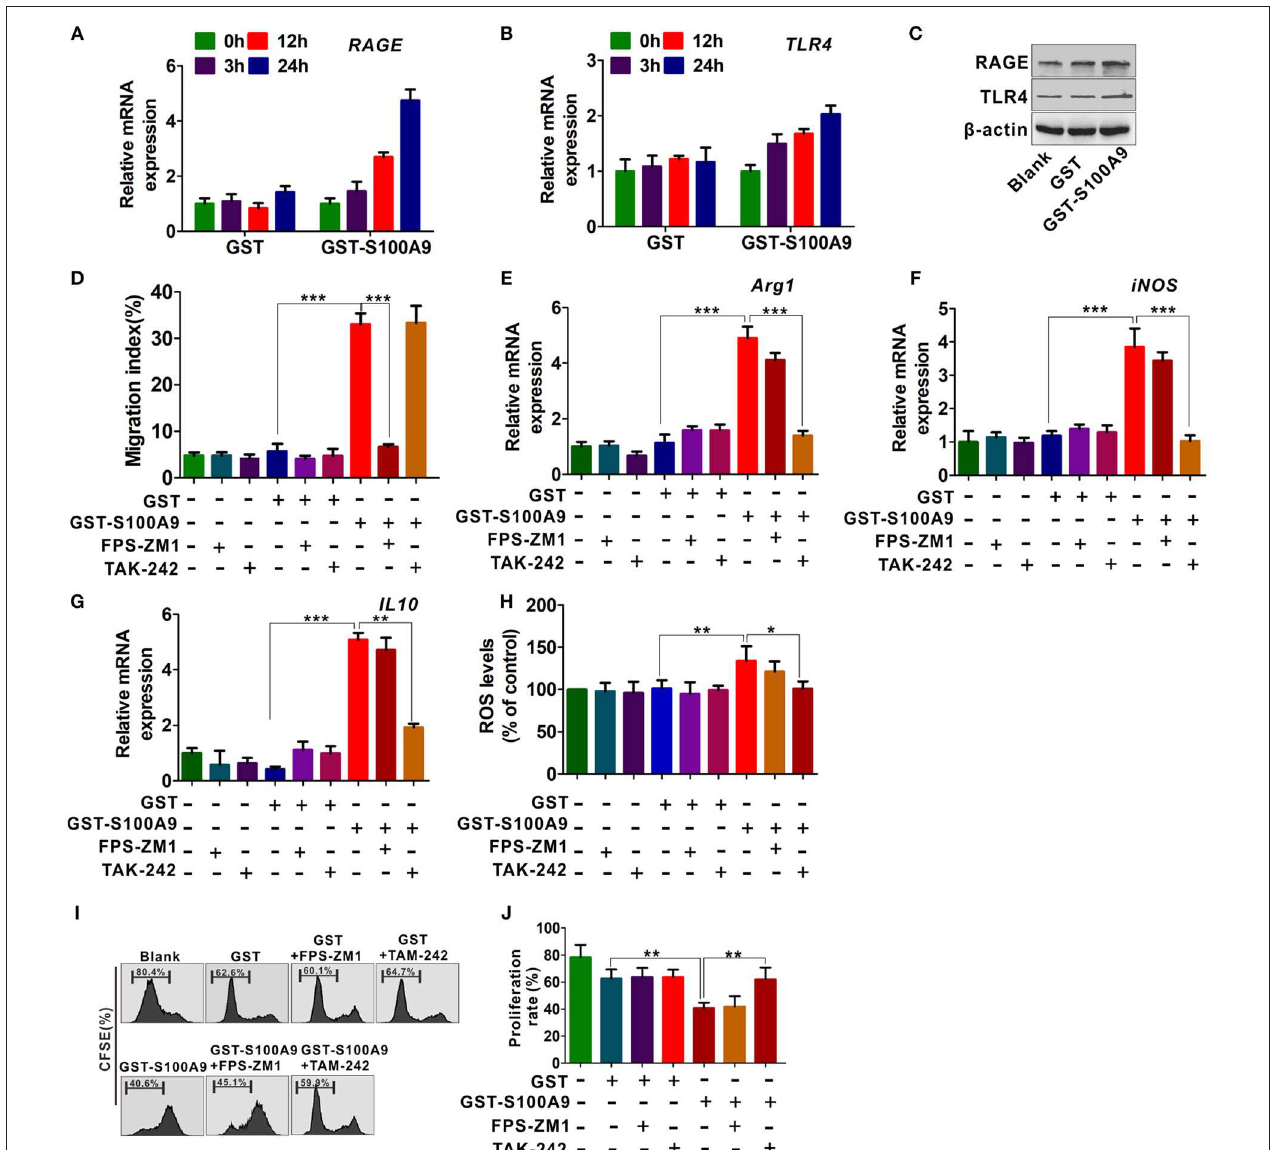
FIGURE 5 | RAGE and TLR4 receptors are responsible for S100A9-mediated MDSCs chemotaxis and activation. (A,B) Real-time quantitation PCR analysis of RAGE (A) and TLR4 (B) mRNA expression in LoVo-induced MDSCs treated with GST-S100A9 (20 µ g/ml) and GST (20 µ g/ml) for 3, 12, and 24h. (C) Western blot analysis of RAGE and TLR4 expression in MDSCs treated with GST-S100A9 (20 µ g/ml) and GST (20 µ g/ml) for 24h. (D) Chemotaxis assay for LoVo-induced MDSCs pretreated with and without inhibitors FPS-ZM1 (100nM) and TAK-242 (100nM) for 30min followed by stimulation with GST-S100A9 (20 µ g/ml) and GST (20 µ g/ml) proteins for 24h. (E–G) Real-time quantitative PCR analysis for mRNA expression of immunosuppressive molecules, including Arg1 (E) , iNOS (F) , and IL10 (G) in LoVo-induced MDSCs pretreated with and without inhibitors FPS-ZM1 (100nM) and TAK-242 (100nM) for 30min followed by stimulation with GST-S100A9 (20 µ g/ml) and GST (20 µ g/ml) proteins for 24h. (H) Fluorescence intensity analysis for ROS production in LoVo-induced MDSCs pretreated with and without inhibitors FPS-ZM1 (100nM) and TAK-242 (100nM) for 30min followed by stimulation with GST-S100A9 (20 µ g/ml) and GST (20 µ g/ml) proteins for 24h. (I) Suppression of LoVo-induced MDSCs pretreated with and without inhibitors FPS-ZM1 (100nM) and TAK-242 (100nM) for 30min followed by stimulation with GST-S100A9 (20 µ g/ml) and GST (20 µ g/ml) proteins on T cells in vitro. (J) A statistical graph of the suppressive effect of LoVo-induced MDSCs pretreated with and without inhibitors FPS-ZM1 (100nM) and TAK-242 (100nM) for 30min followed by stimulation with GST-S100A9 (20 µ g/ml) and GST (20 µ g/ml) proteins on CD8 + T cells. Data represent three independent experiments and are represented as Mean ± SD. * p < 0.05, ** p < 0.01, *** p < 0.001.